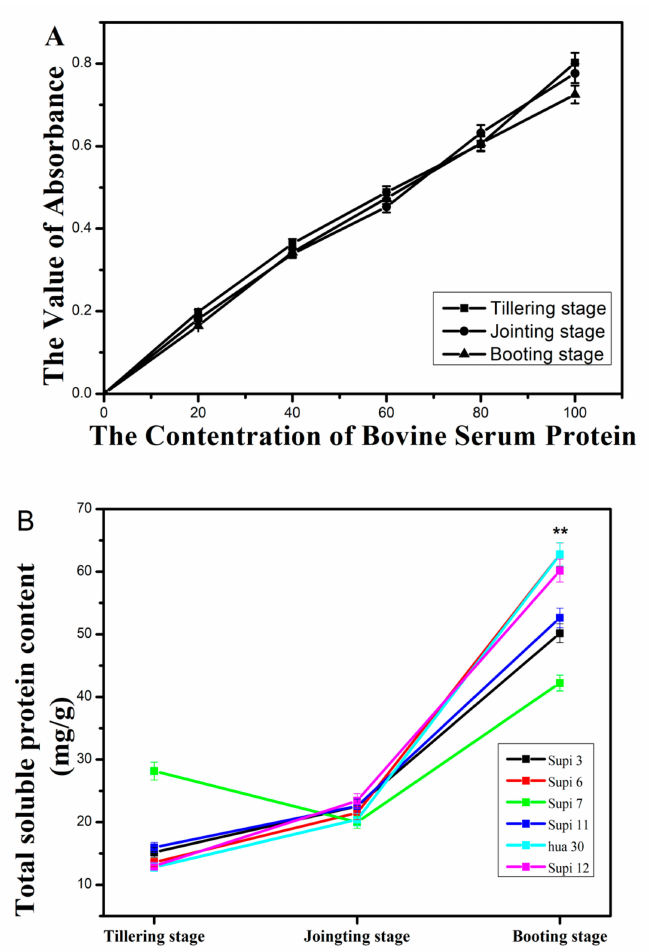
Figure 2. Standard curve of soluble protein of bovine serum at di ff erent developmental stages ( A ) and the total soluble proteins (TSP) in the six barley cultivars at di ff erent developmental stages ( B ). Data represent mean values standard deviation (SD) from three independent experiments. Bars show standard deviations of the mean. Asterisks on top of the bars indicate statistically significant di ff erences ( ** p < 0.01, Student’s t